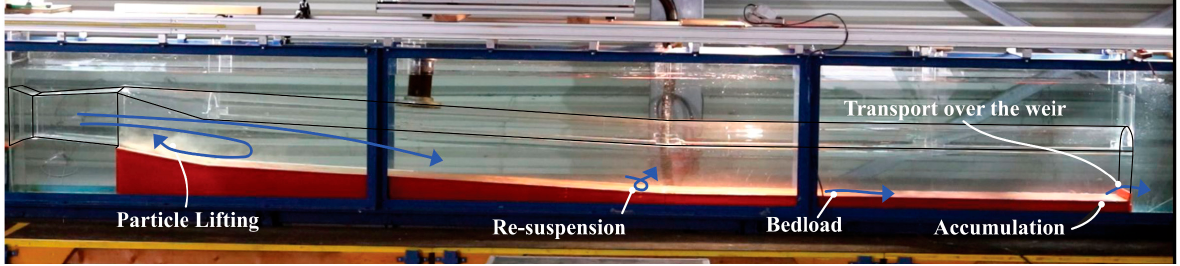
Figure 10. Visualized summary of particle transport mechanisms in case study pressurized sand trap.